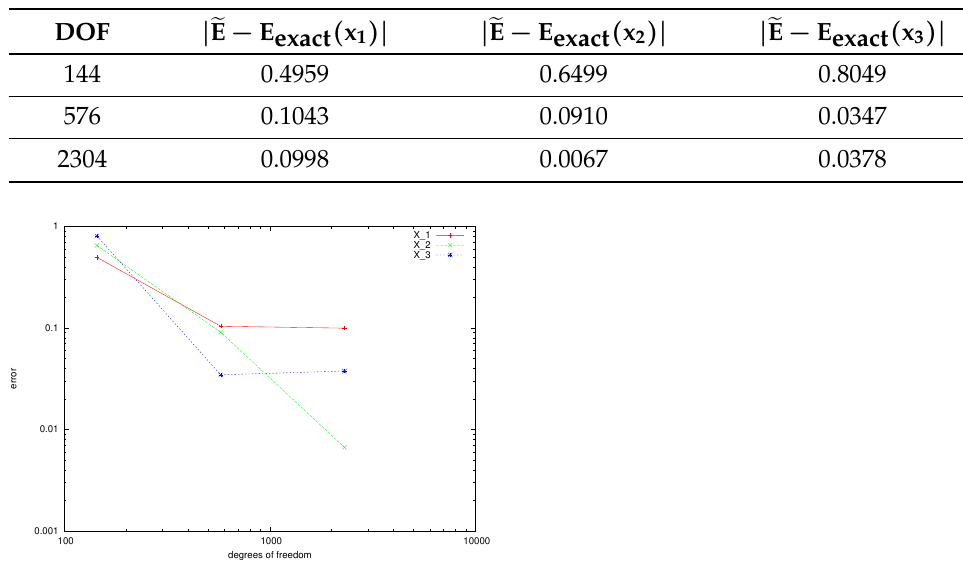
Table 2. Errors for electrical field in x 1 , x 2 , and x 3 .